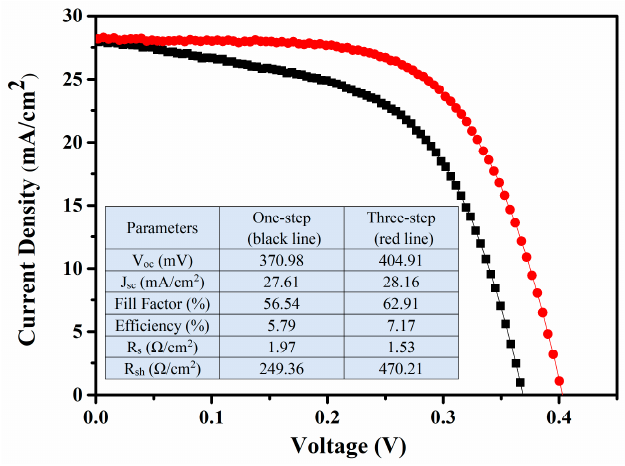
Figure 5. J-V characteristics of the CZTSSe solar cells prepared by the one-step and three-step selenization process.